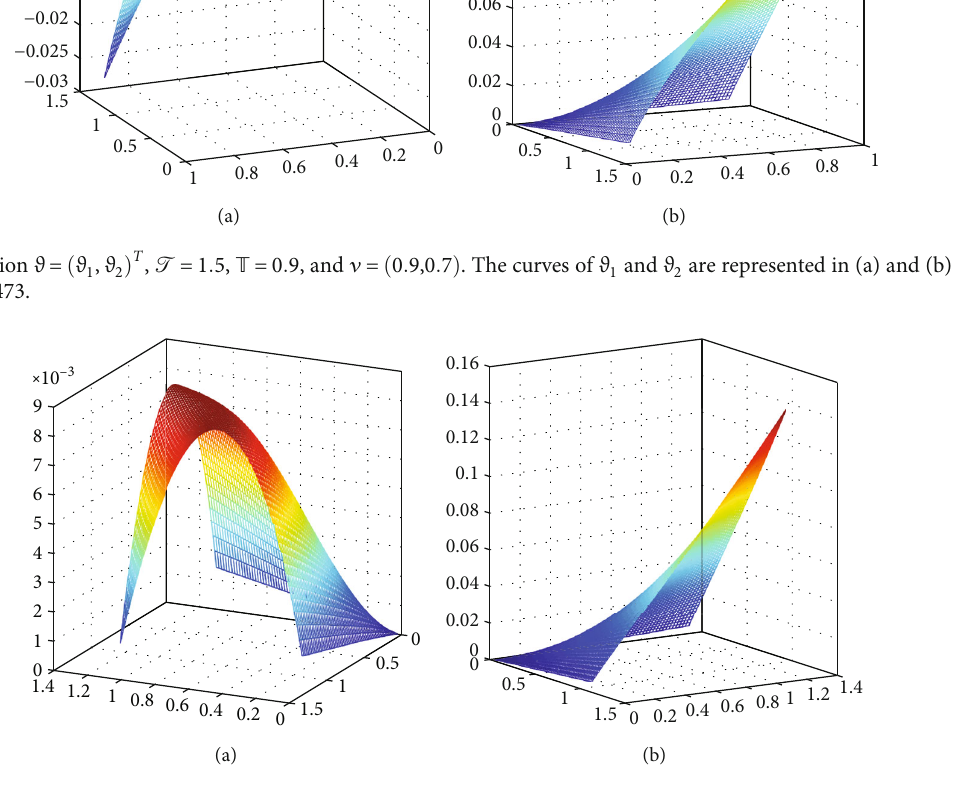
, ϑ T , T = 1 : 092 , T = 1 : 3 , and ν = ð 0 : 9,0 : 9 Þ . The curves of ϑ 1 2 Þ